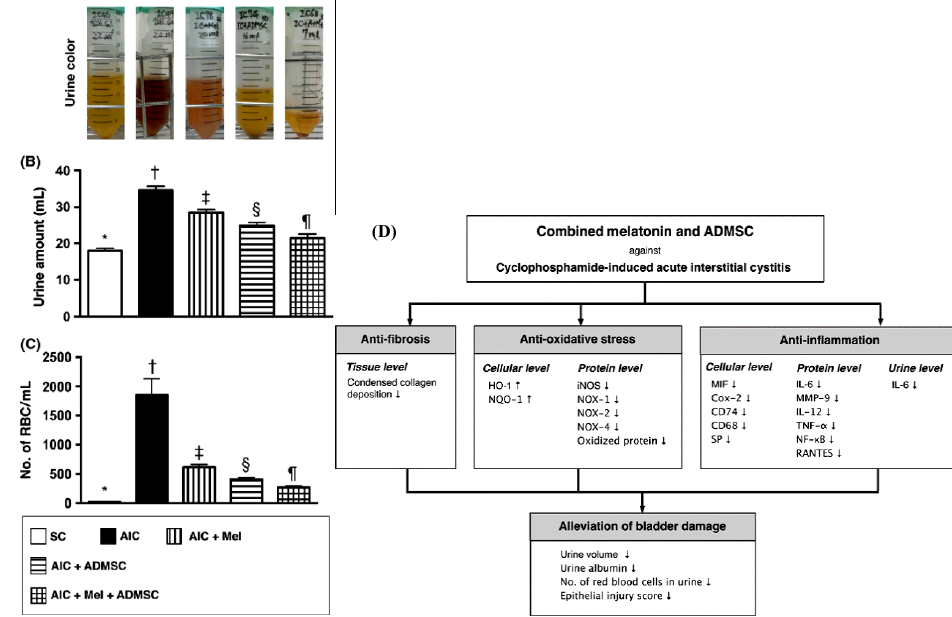
Figure 3. E ff ect and mechanisms of combination therapy with adipose-derived mesenchymal stem cells (AD-MSCs) and melatonin in cyclophosphamide (CYP)-induced acute interstitial cystitis (AIC). ( A ) The AIC group showed the highest urine turbidity and hematuria compared to the other groups. In contrast, the group treated with the combination of AD-MSCs and melatonin showed markedly lower urine turbidity than the groups treated with AD-MSCs or melatonin alone. This test was carried out for 72 h after AIC induction. ( B ) The urine amount was recorded on the last day of the 72-h period after AIC induction. ( C ) Number of red blood cells (RBCs) per mL of urine. ( D ) The mechanisms underlying the e ff ects of the combination of AD-MSCs and melatonin in CYP-induced AIC therapy. These figures were reproduced from articles by Chen et al. 2014 [163] with permission from John Wiley and Sons. TGF- β 1, transforming growth factor-beta 1. EB, embryoid bodies. HEMA, hydroxyethyl methacrylate. HO, heme oxygenase. iNOS, inducible nitric oxide synthase. NOX, NADPH oxidase. NF- κ B, nuclear factor kappa-light-chain-enhancer of activated B cells. NQO, NAD(P)H quinone oxidoreductase. MMP-9, matrix metalloproteinases-9. IL, interleukin. AIC, acute interstitial cystitis. TNF- α , tumor necrosis factor- α . MIF, macrophage migration inhibitory factor. SP, substance P. RBCs, red blood cells. Down arrow, downregulation. Up arrow,